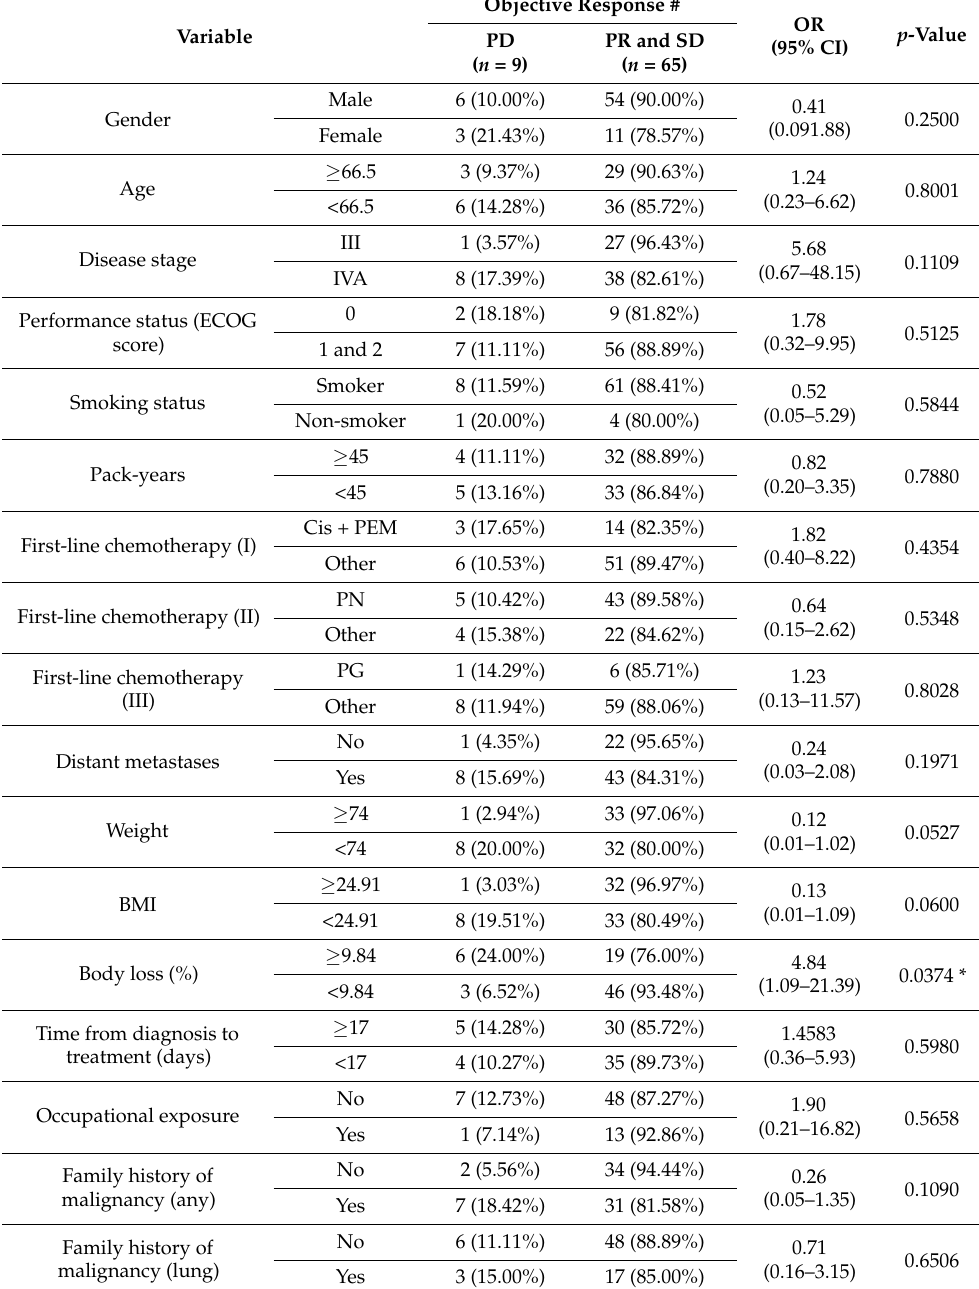
Table 3. Risk of disease progression according to demographic, clinical, and genetic factors (first